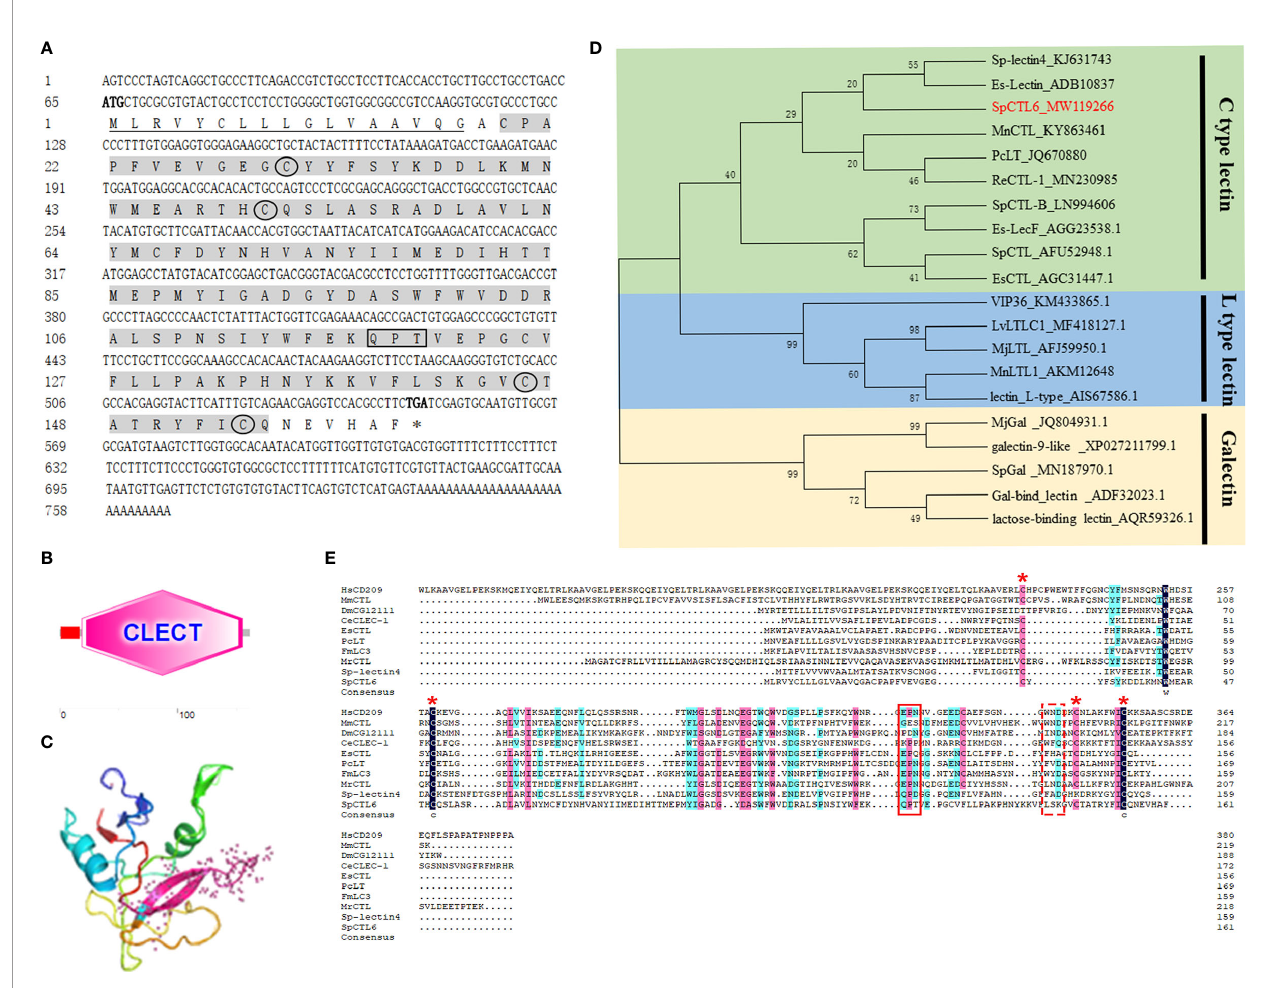
FIGURE 1 | Bioinformatics and phylogenetic analysis of SpCTL6. (A) The nucleotide sequence and deduced amino sequence of SpCTL6 from Scylla paramamosain . Start codon (ATG) and stop codon(TGA) are marked in bold. The signal peptide is underlined and the CTLD is shade with gray. Four conserved residues are circled and the carbohydrate binding motif (QPT) is boxed. (B) Schematic representation of the structural domain of SpCTL6 protein predicted by SMART. (C) A predicted three-dimensional model of SpCTL6 by SWISS-MODEL program. (D) Phylogenetic tree analysis of SpCTL6. A neighbor-joining phylogenetic tree of lectins was constructed using MEGA ver.6.0 software with 1000 bootstrap replications. SpCTL6 was shown in red. (E) Multiple sequence alignment of CTLs from various species. Amino acids residues that are completely conserved are shaded in dark blue, and similar amino acids are shaded in red or light blue. Four conserved cysteine residues involved in the formation of the disul fi de bridges are marked with red asterisks, the carbohydrate binding motif (QPT) is boxed with solid line and the WND motif is boxed with dot line. The information of the sequences are listed as follows: HsCD209 ( Homo sapiens , AAI10616), MmCTL ( Mus musculus AAD05125), DmCG12111 ( Drosophila melanogaster , AAF46391), CeCLEC-2 ( C. elegans , CCD61973), EsCTL ( E. sinensis , JX841199), PcLT ( Procambarus clarkia , JQ670880), FmLC3 ( Fenneropenaeus merguiensis , JF430082), MrCTL ( Macrobrachium rosenbergii , KX495215), Sp-lectin4 ( S. paramamosain , KJ631743), SpCTL6 ( S. paramamosain ,